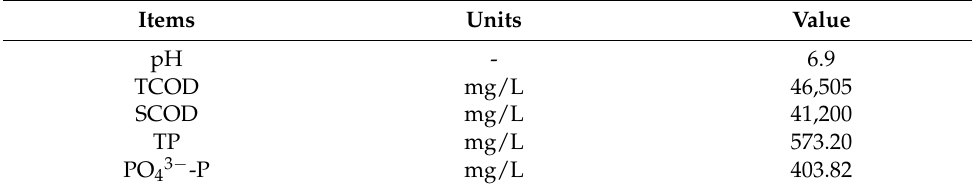
Table 1. Basic parameters of sludge